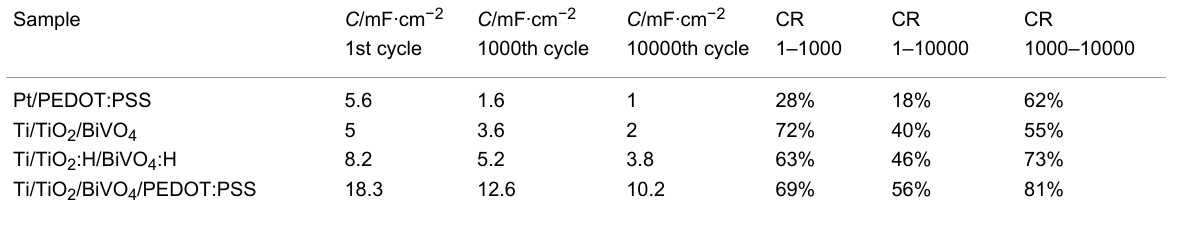
Table 1: The comparison of capacitance values for 1st, 1000th, and 10000th cycle. Capacity retention (CR) calculated between 1st and 1000th cycle, between 1st and 10000th cycle, and between 1000th and 10000th cycle.